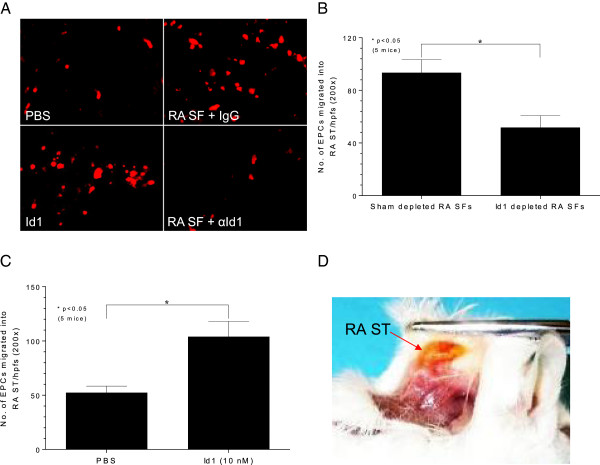
RA ST SCID mouse chimera. After a four-week engraftment period, mice were injected i.v. with 2.5 × 105 fluorescently dye-tagged human endothelial progenitor cells (EPCs) while receiving simultaneous intragraft injections of rheumatoid arthritis (RA) synovial fluid (SF) (100 μl) that was either “sham” immunoneutralized with non-specific IgG or immunoneutralized with specific antibody to human Id1. In some experiments, RA synovial tissue (ST) SCID chimeric mice received dye-tagged EPCs while receiving simultaneous intragraft injections of human Id1 (10 nM) or PBS. A) Section from a SCID mouse injected with Id1 or sham immunodepleted RA SF showing significantly elevated EPC migration to the engrafted RA ST injected with “sham” immunodepleted RA SF. B) Approximately 50% fewer EPCs migrated to engrafted RA ST injected with Id1 neutralized from RA SF compared to sham injected RA SF (n = 10 sections from five mice (that is, two sections/mouse)). C) Less than 50% fewer EPCs migrated to engrafted RA ST in chimeric mice when injected intragraft with phosphate-buffered saline (PBS) compared to Id1 (n = 10 sections from five mice (that is, two sections/mouse)). D) Engrafted RA ST in the SCID mouse chimera.